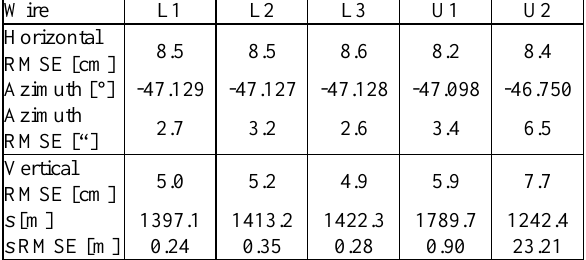
Table 4. Results of robust fitting of wires to the point cloud segments